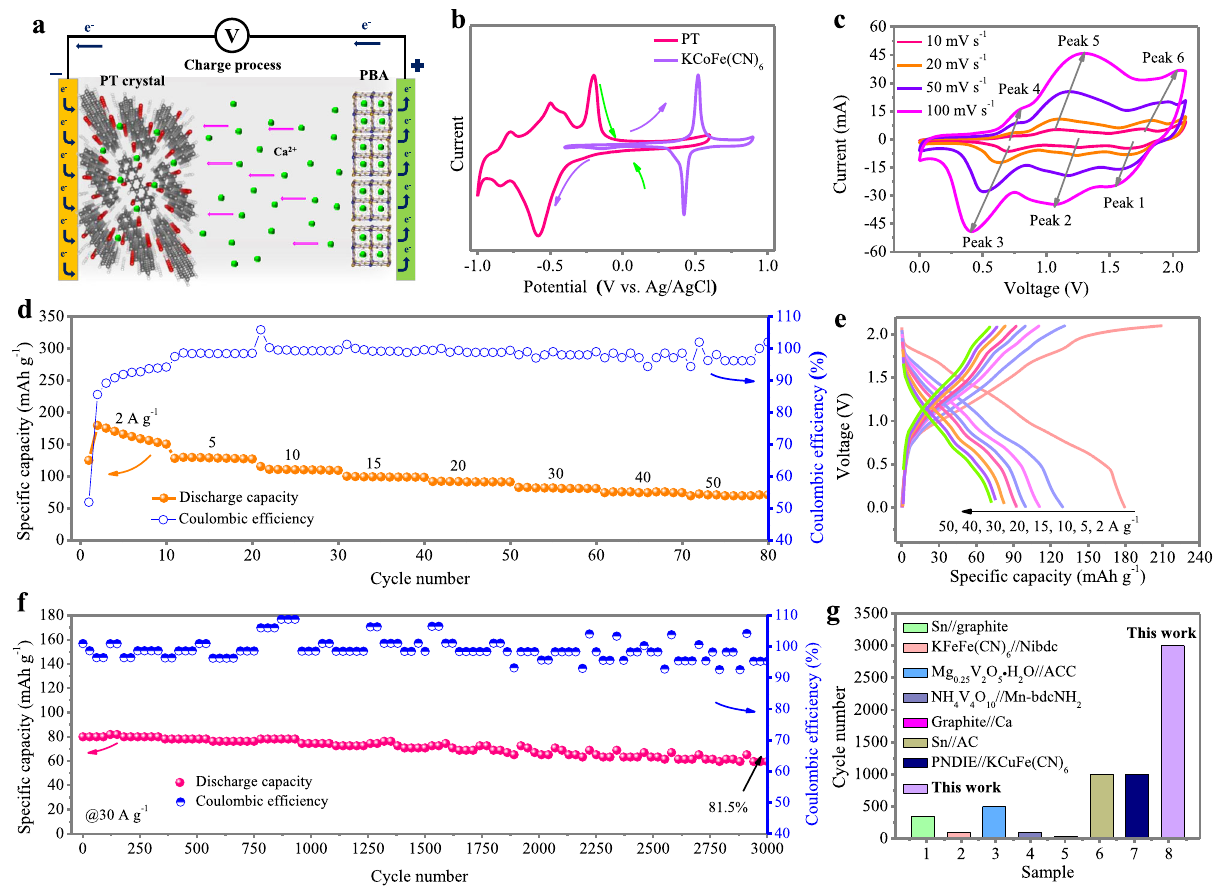
Fig. 8 Full aqueous Ca-ion cell based on PT anode and KCoFe(CN) 6 PBA cathode. a Schematic illustration of the reaction mechanism of the PT//PBA full cell. b Comparison of the CV curves of PT anode and PBA cathode. c The CV curves for the full cell at scan rates of 10 – 100 mV s − 1 . d The rate capability at different speci fi c currents. e the GCD curves at different speci fi c currents. f Cycle performance at 30 A g − 1 . g Cycle performance comparison with literature. See Supplementary Table 2 for reported data in